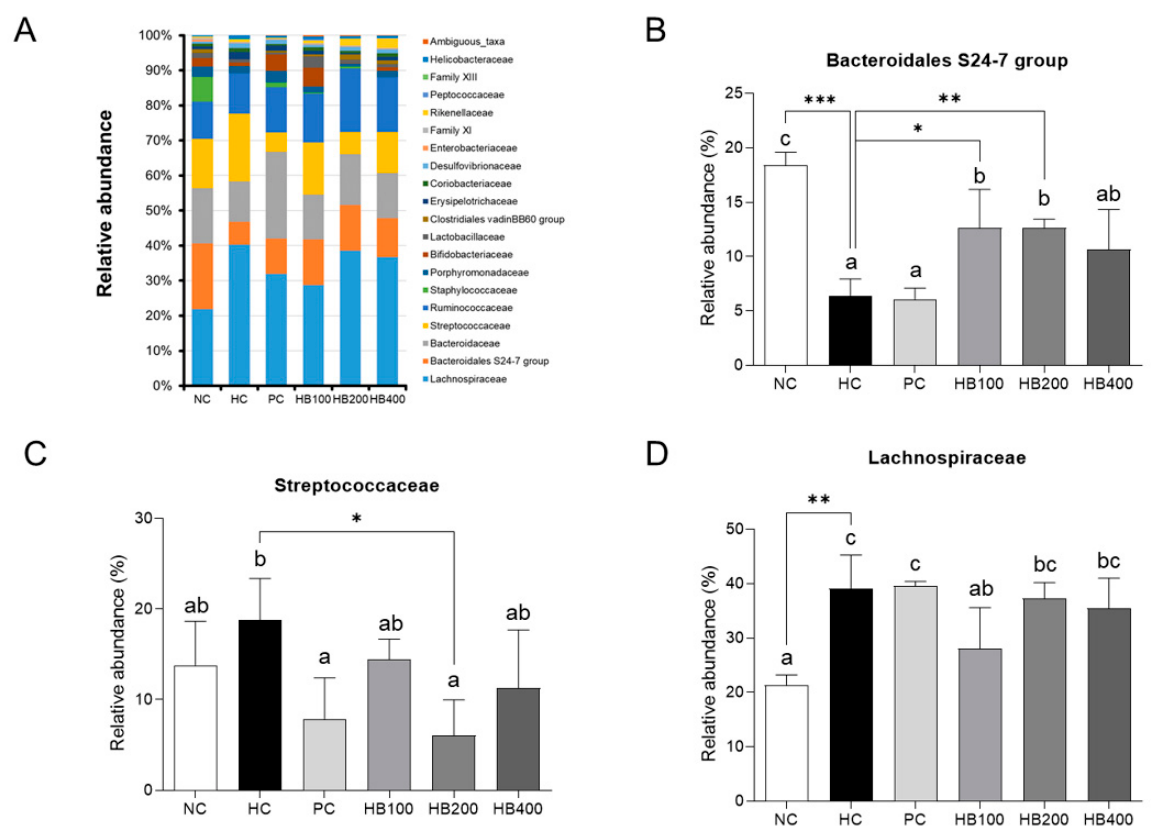
Figure 6. Fecal microbial relative abundance of family. ( A ) Bar plot of relative bacterial family abundance. All data are mean ± SD. Significant differences among six groups are expressed as different letters based on one-way ANOVA ( p < 0.05), followed by Duncan’s multiple range tests. * p < 0.05, ** p < 0.01, *** p < 0.001 versus HC group. The group means were compared by Student’s t -test.